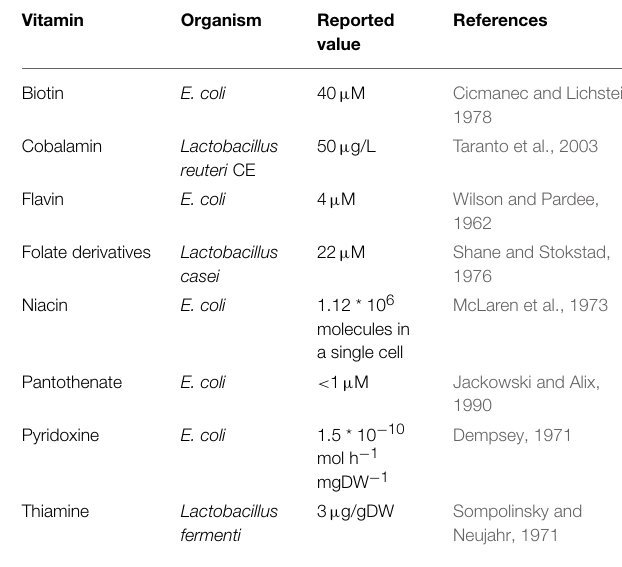
TABLE 2 | Combinations of essential functional roles for the biosynthesis the B-vitamins. Pathway